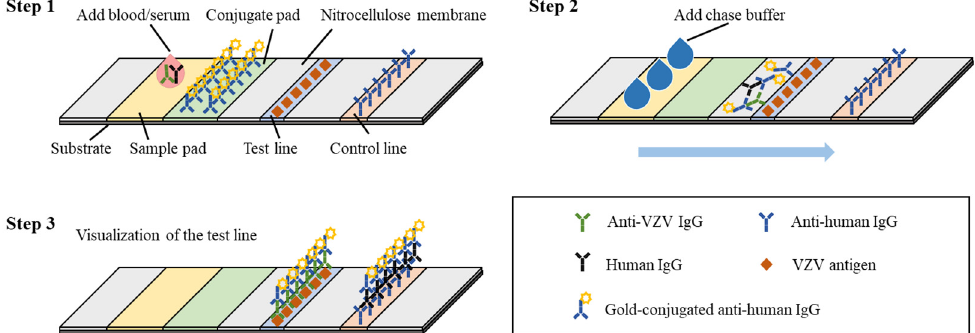
Figure 8. The fabricated LFIA strip for the detection of anti ‐ VZV antibodies comprises of a base nitrocellulose membrane, a sample loading pad, a conjugate pad with immobilized gold ‐ conjugated anti ‐ human IgG, a test line with pre ‐ absorbed VZV antigen (e.g., VZV gE) and a control line that serves to confirm if the strip is working. The basic steps of LFIA are as follows: (1) Add 15 to 20 μ L of whole blood or serum to the sample pad of the strip. (2) Add three drops of chase buffer to allow migration of gold ‐ antibody complexes onto the test line and the control line. (3) Anti ‐ VZV antibodies in the sample are captured by the VZV antigen in the test line, and the presence of both a control line and a test line is used to define a VZV ‐ positive test result.